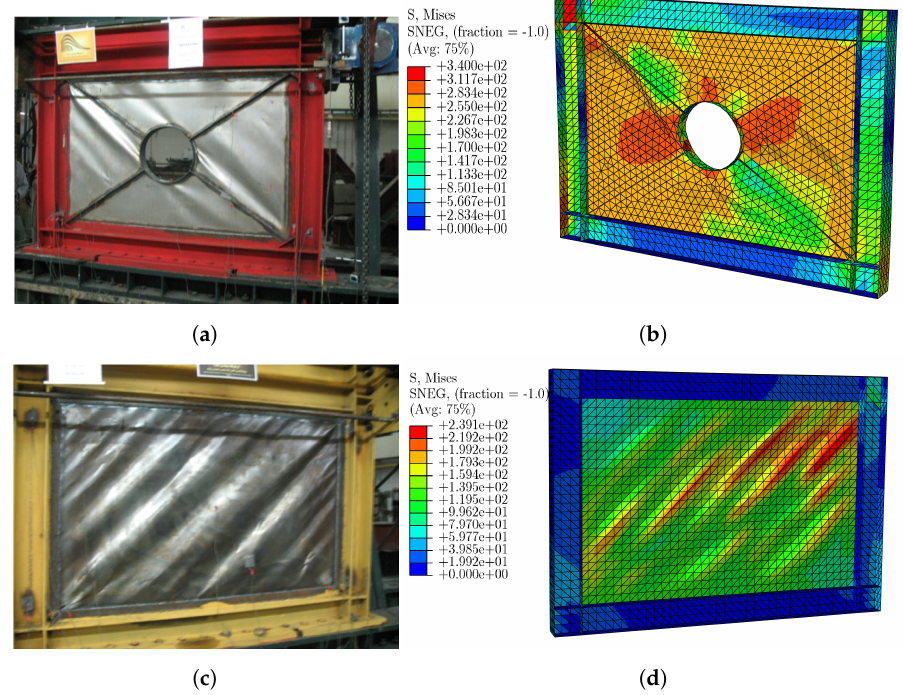
Figure 3. Comparison of finite element (FE) simulated models and tested specimens at ultimate displacement: ( a ) deformation in SPSW s4 specimen, ( b ) von Mises stress distribution and deformation in FE model of SPSW s4, ( c ) deformation in SPSW2 specimen, ( d ) von Mises stress distribution and deformation in FE model of